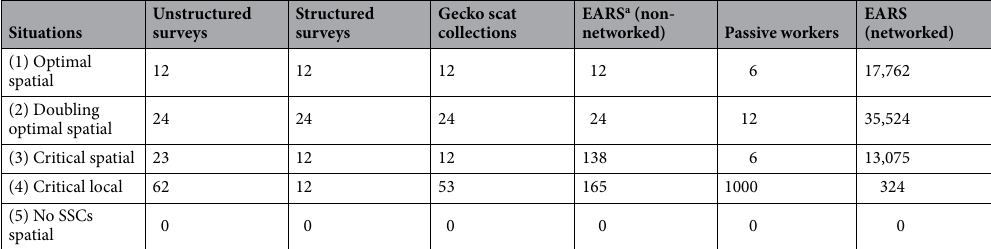
Table 1. Quantity of corresponding Surveillance System Components (SSCs, see definitions of SSCs in Supplementary Table S2) to be used in each situation when estimated population threshold for detection is ˜ K = 8 ) and annual number of entries of Asian house gecko individuals after border inspection to eight ( L ˜ En = 5 any of the locations on Barrow Island is five ( ). ‘Spatial’ indicates the situation with spatial spread model applies and ‘Local’ indicates the situation with local spread model applies. ‘Critical’ indicates that the surveillance programme is designed to critically achieve Gorgon’s ministerial commitment. a EARS: Environmental Acoustic Recognition Sensors. These are devices that autonomously listen for the call of an Asian House Gecko and relay any detections to the end user through a user